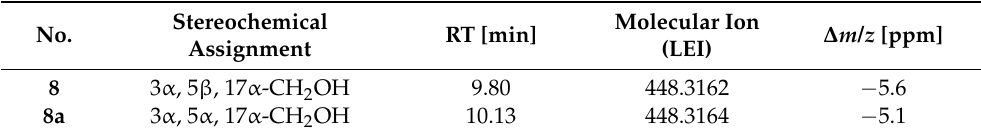
13 C NMR spectral data of 17 α -hydroxymethyl-17 β -methyl-18-nor-5 β -androst-13-en-3 α -ol (8) and 17 α - Table 2. 1 H and hydroxymethyl-17 β -methyl-18-nor-5 α -androst-13-en-3 α -ol (8a). Multiplicity of signals indicated as singlet (s), doublet (d). 17 α -hydroxymethyl-17 β -methyl-18-nor-5 β -an-